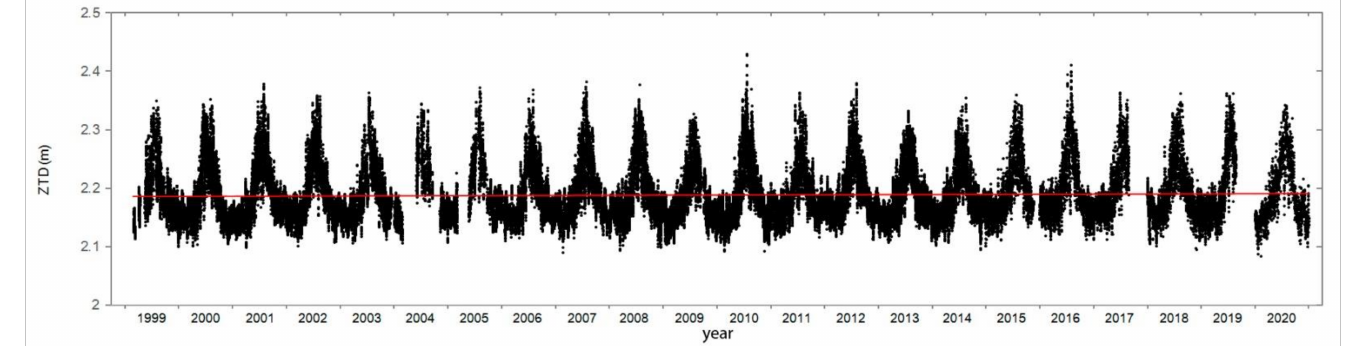
Figure 1. ZTD time series obtained at IRKM from 1999 to 2020. The red line is the linear